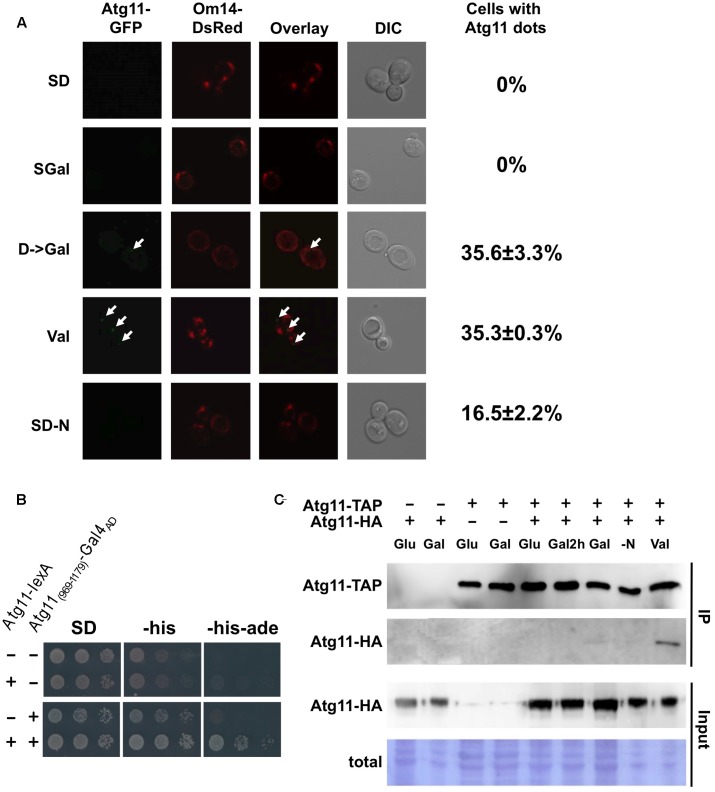
Valinomycin-mediated damage induces Atg11 oligomerization and Atg11 containing autophagosomal bodies near mitochondria. (A) Endogenously expressed Atg11-GFP was visualized in yeast cells grown in glucose (SD), galactose (SGal), shifted for 2 h from glucose to galactose, treated for 2 h with valinomycin (4 μM), or depleted for nitrogen for 2 h. The outer mitochondrial membrane protein Om14 fused to dsRed was used to stain the entire mitochondrial network. The appearance of Atg11 dots is indicated with arrows in the micrographs. The percentage of cells with Atg11 autophagosomal bodies is given at the right and was determined from > 50 individual cells in two independent experiments. The mean values including the standard error are indicated. (B) The C-terminal (969–1179) domain of Atg11 is sufficient for homo dimerization. Full length Atg11 expressed as a lexA fusion from plasmid pBTM116 and/or Gal4AD-Atg11(969-1179) expressed from plasmid pACT2 was used as indicated in yeast THY.AP4 strain. Two hybrid interaction was confirmed by growth in media lacking histidine and adenine. (C) Atg11 dimerization is stimulated by valinomycin exposure in vivo. Yeast strains expressing endogenous Atg11-TAP and/or plasmid encoded Atg11-HA were grown in glucose (SD), galactose (Gal), shifted for 2 h from glucose to galactose (Gal2h), treated for 2 h with 4 μM valinomycin (Val), or depleted for nitrogen for 2 h (–N).